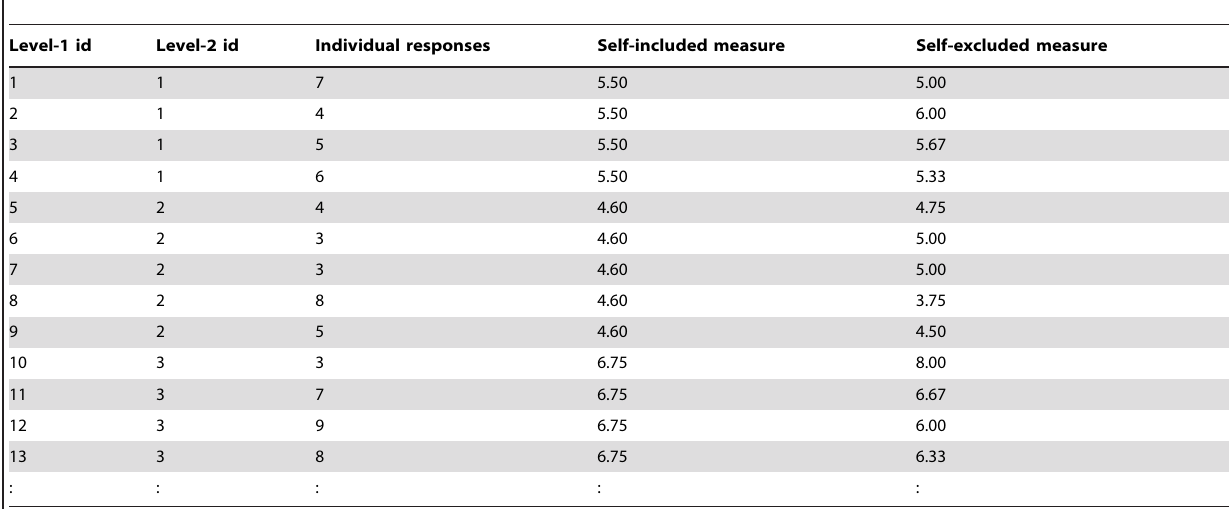
Table 1. Example of a hypothetical data set.